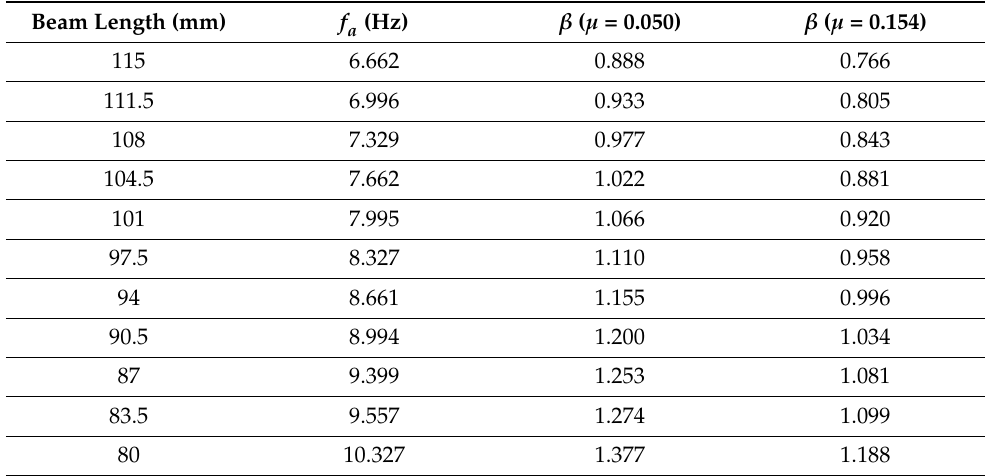
Figure 11. Flow chart of the experimental system.